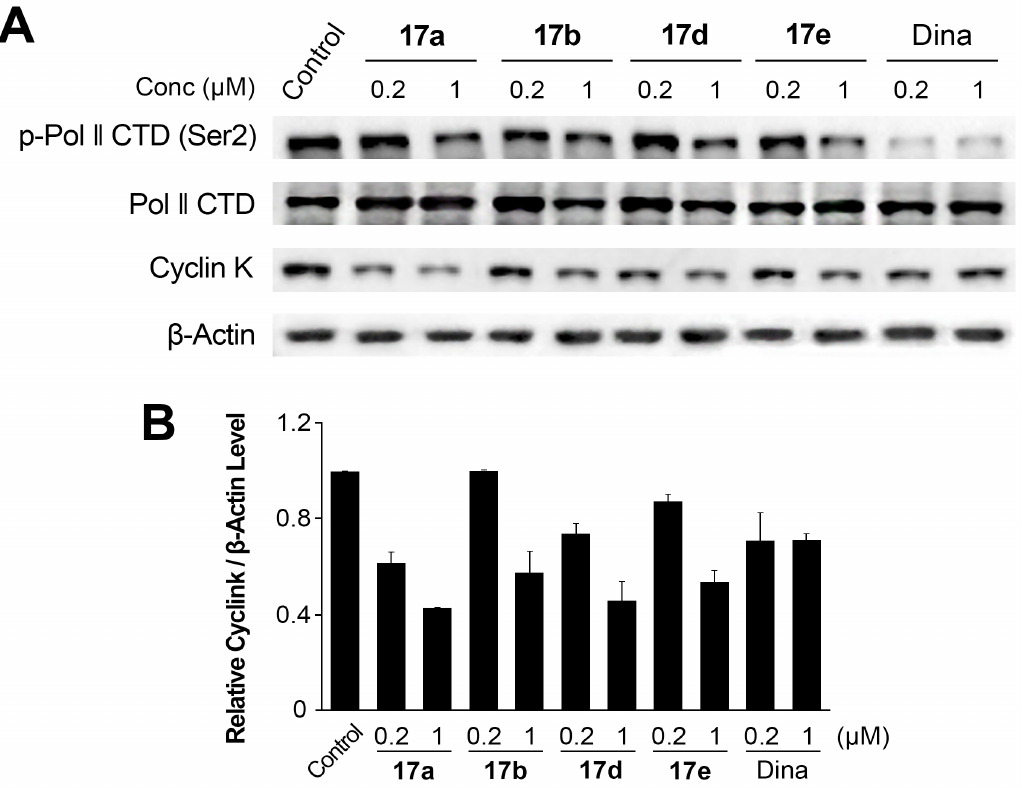
Figure 4. Four compounds ( 17a , 17b , 17d , 17e ), which contain different terminal pyridyl groups at C6 position but exhibit similar in vitro CDK12/cyclinK activity, downregulated Pol II p-CTD (Ser2) and cyclinK in a dose-dependent manner. Compounds at indicated concentrations were treated to SK-Br3 cells for 2 h. ( A ) Western blot analysis result. ( B ) Quantitation of relative cyclinK levels normalized to β-actin levels using ImageJ software. Control = DMSO. Dina = dinaciclib. Next, we investigated SAR for 2 position. A variety of aryl or heteroaryl groups were attached to 2 position of the intermediate 16f to afford 18a–n , 19a–c , and 21a–b (Scheme 2). The aniline NH 2 group of 19a–c was subjected to alkylation to produce N -hydroxyalkyl